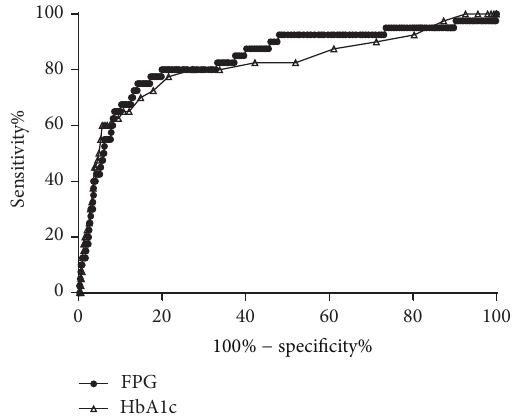
Figure 5: Receiver operating characteristic curves of glycated hemoglobin A1c (HbA1c) and fasting plasma glucose (FPG) for detecting diabetic retinopathy in the total 3124 subjects.